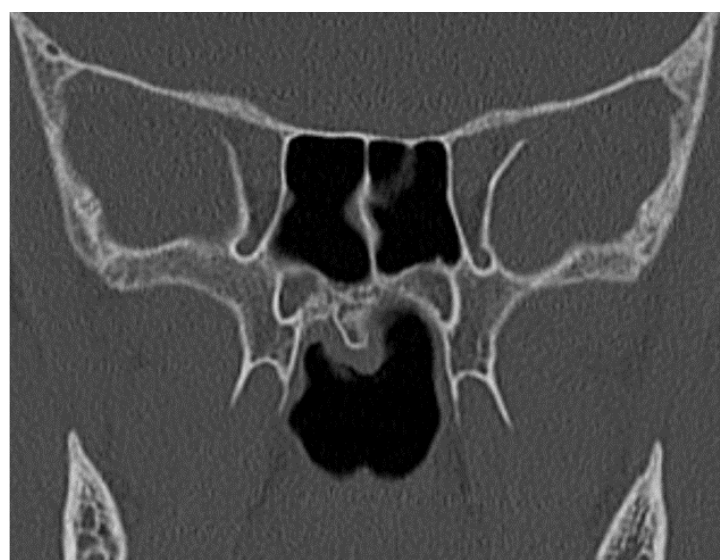
Figure 3. Eccentric and dysmorphic rostrum .